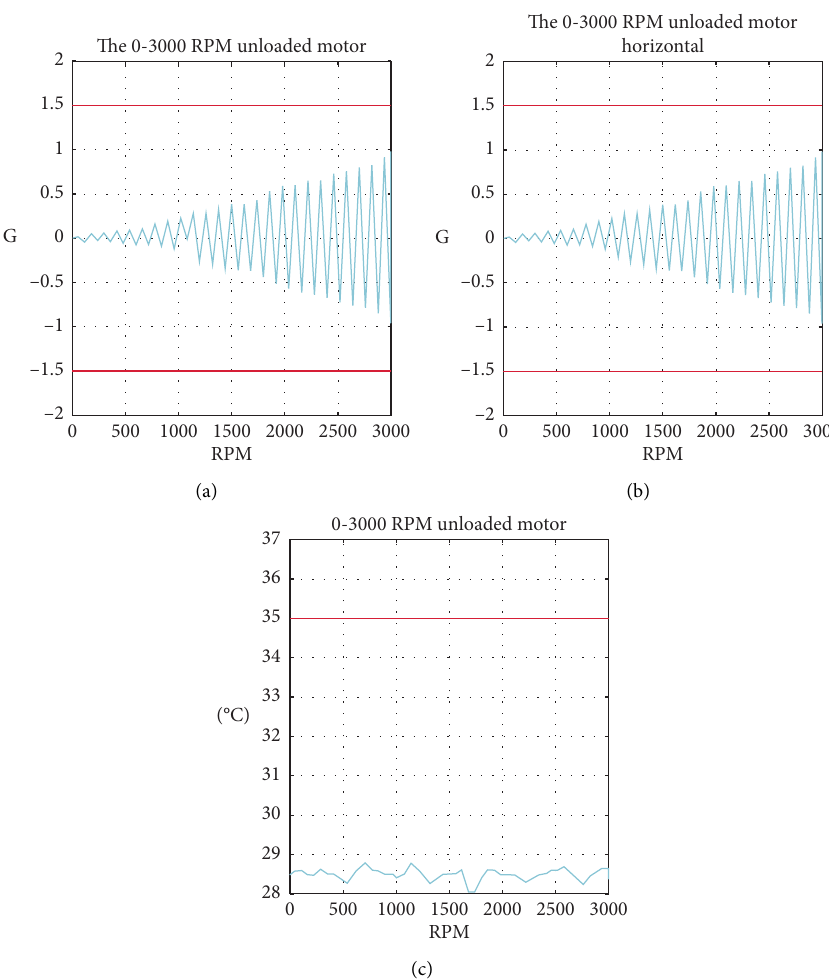
Figure 5: The 0–3000 RPM measurement-speed graph of the unloaded motor: (a) vertical axis, (b) horizontal axis, and (c) temperature- speed graph of the unloaded